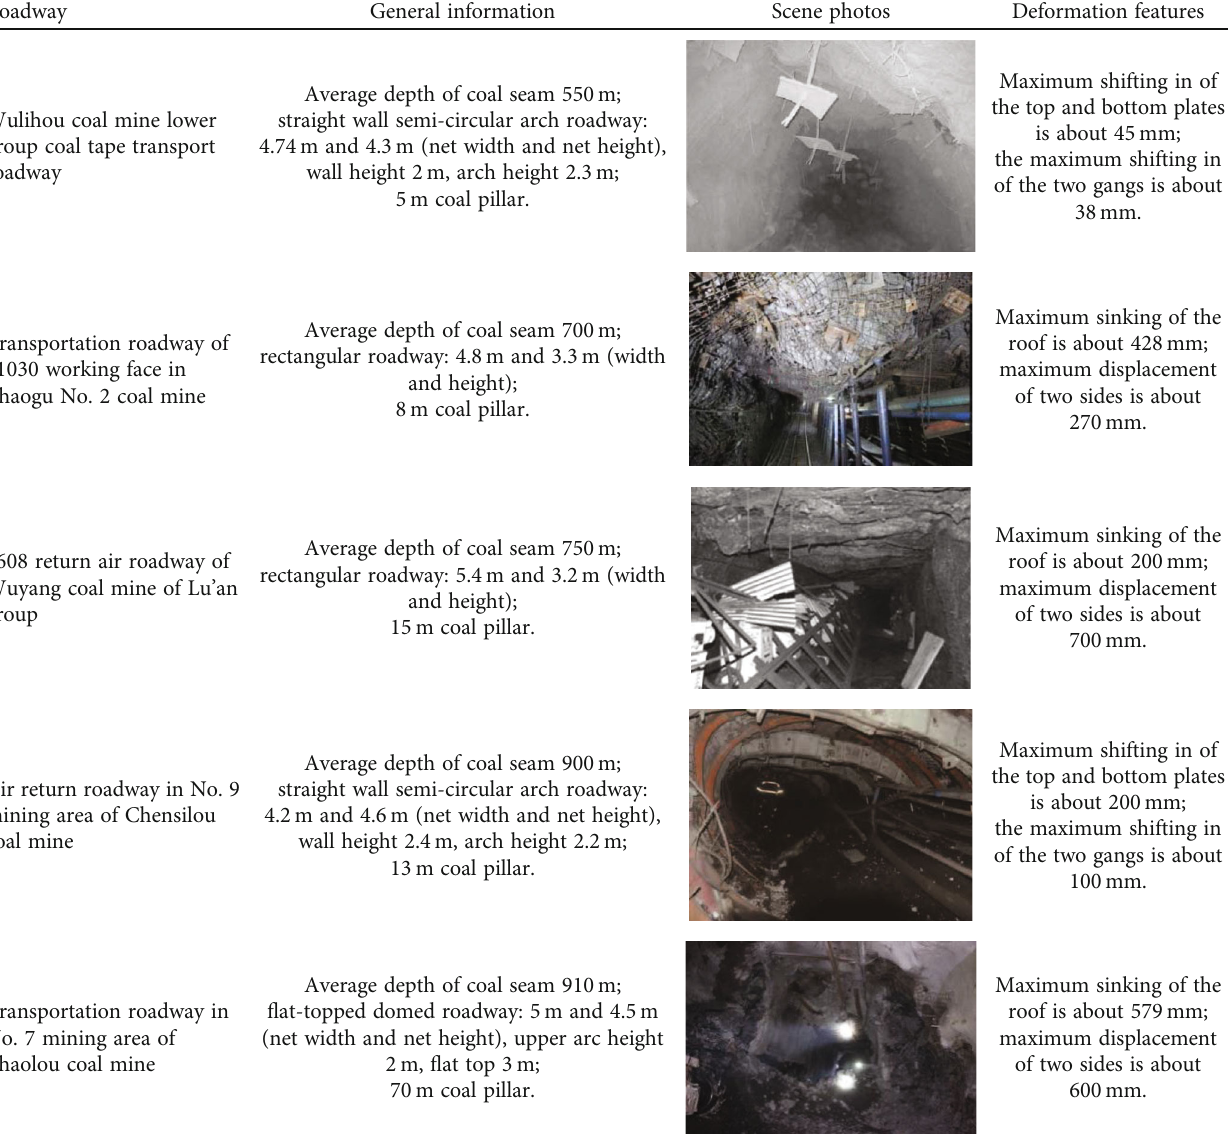
Table 1: Deformation characteristics of surrounding rock in roadway